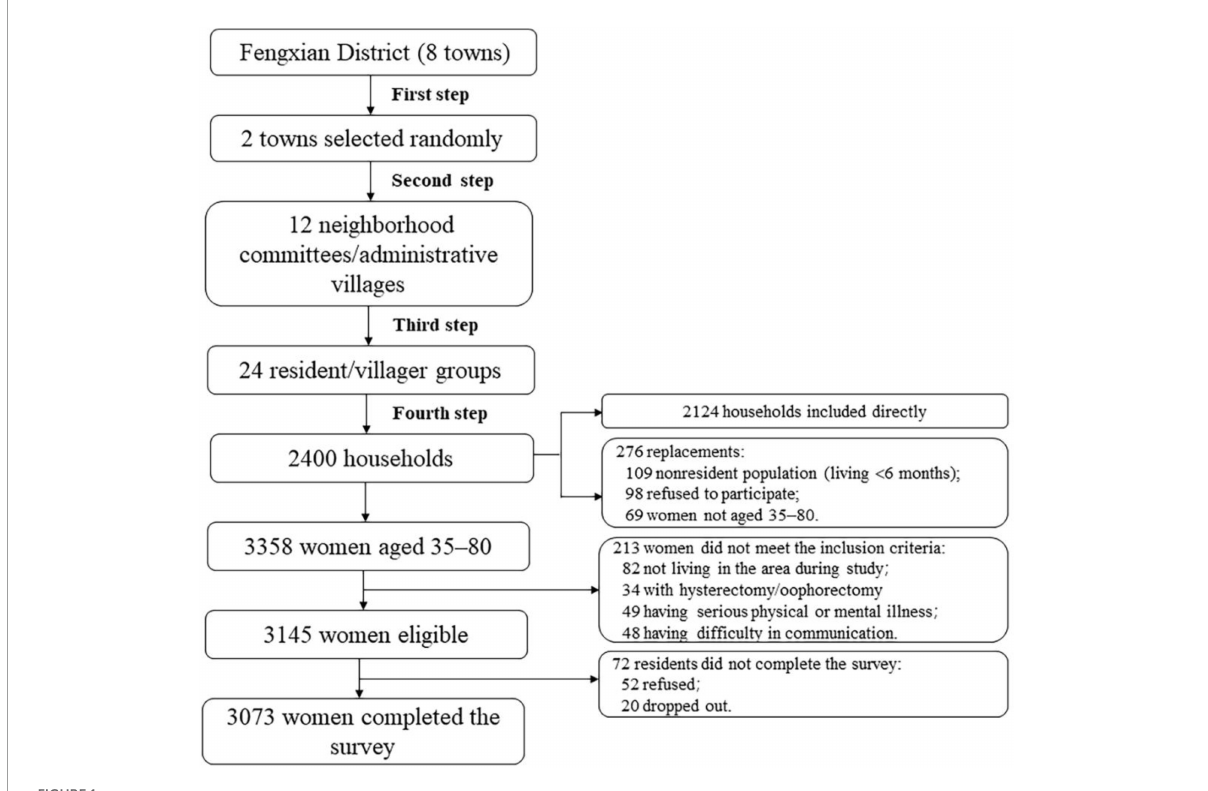
FIGURE1 Flowchart of sampling